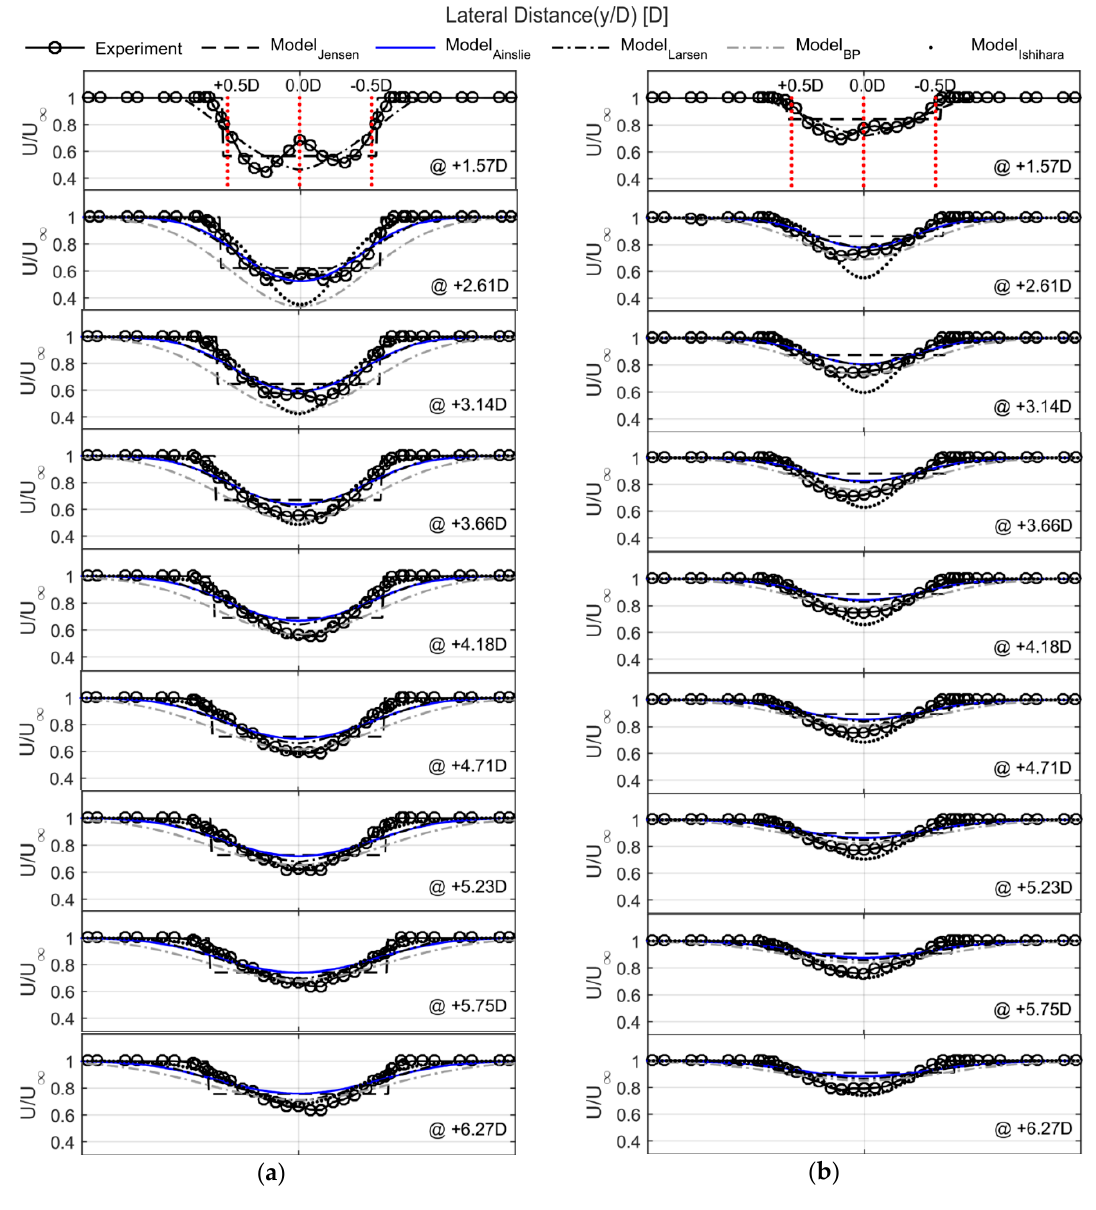
Figure 5. Comparison of the normalized wind profile with the downstream distance: ( a ) below rated case ( C T = 0.8); ( b ) above rated case ( C T = 0.36).